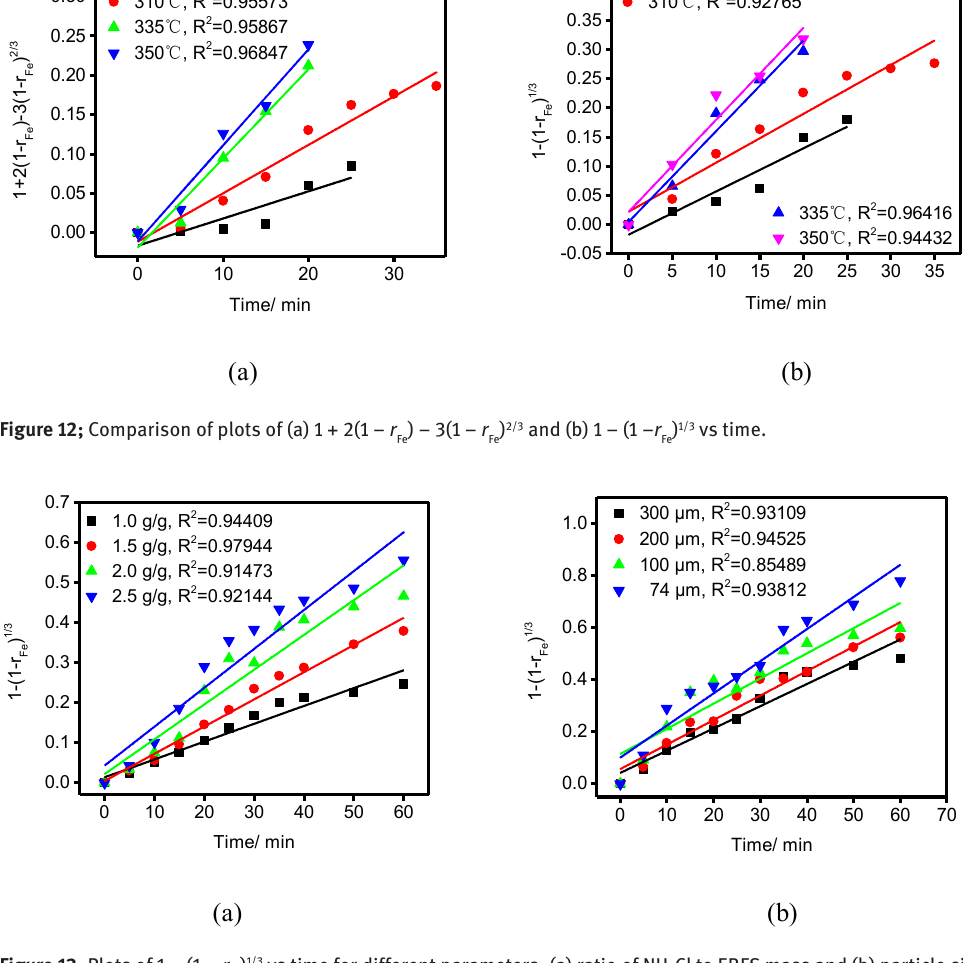
Figure 12. Comparison of plots of (a) 1 + 2(1 − r Fe ) − 3(1 − r Fe ) 2/3 and (b) 1 − (1 − r Fe ) 1/3 vs time